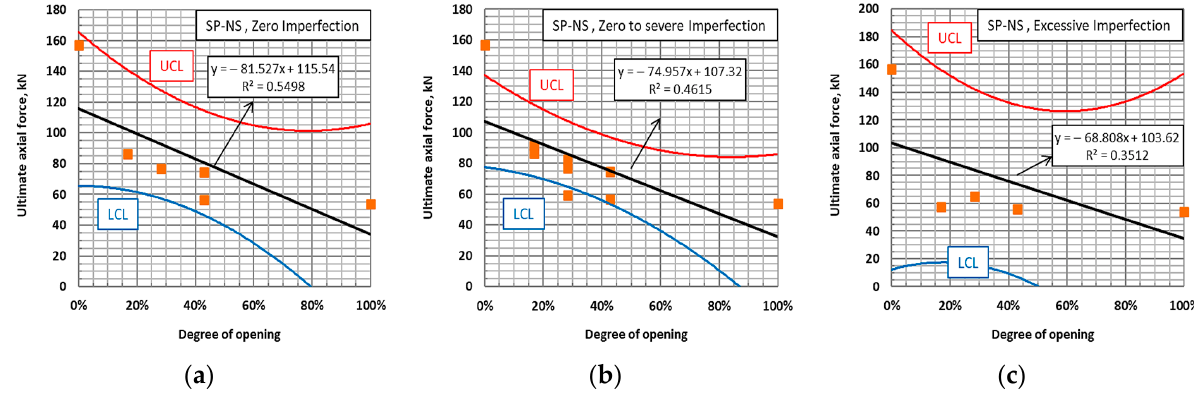
Figure 18. Mean value, UCL and LCL of ultimate axial force as a function degree of opening, SP-NS, ( a )-zero imperfection, ( b )zero to severe imperfection and ( c )-excessive imperfection.